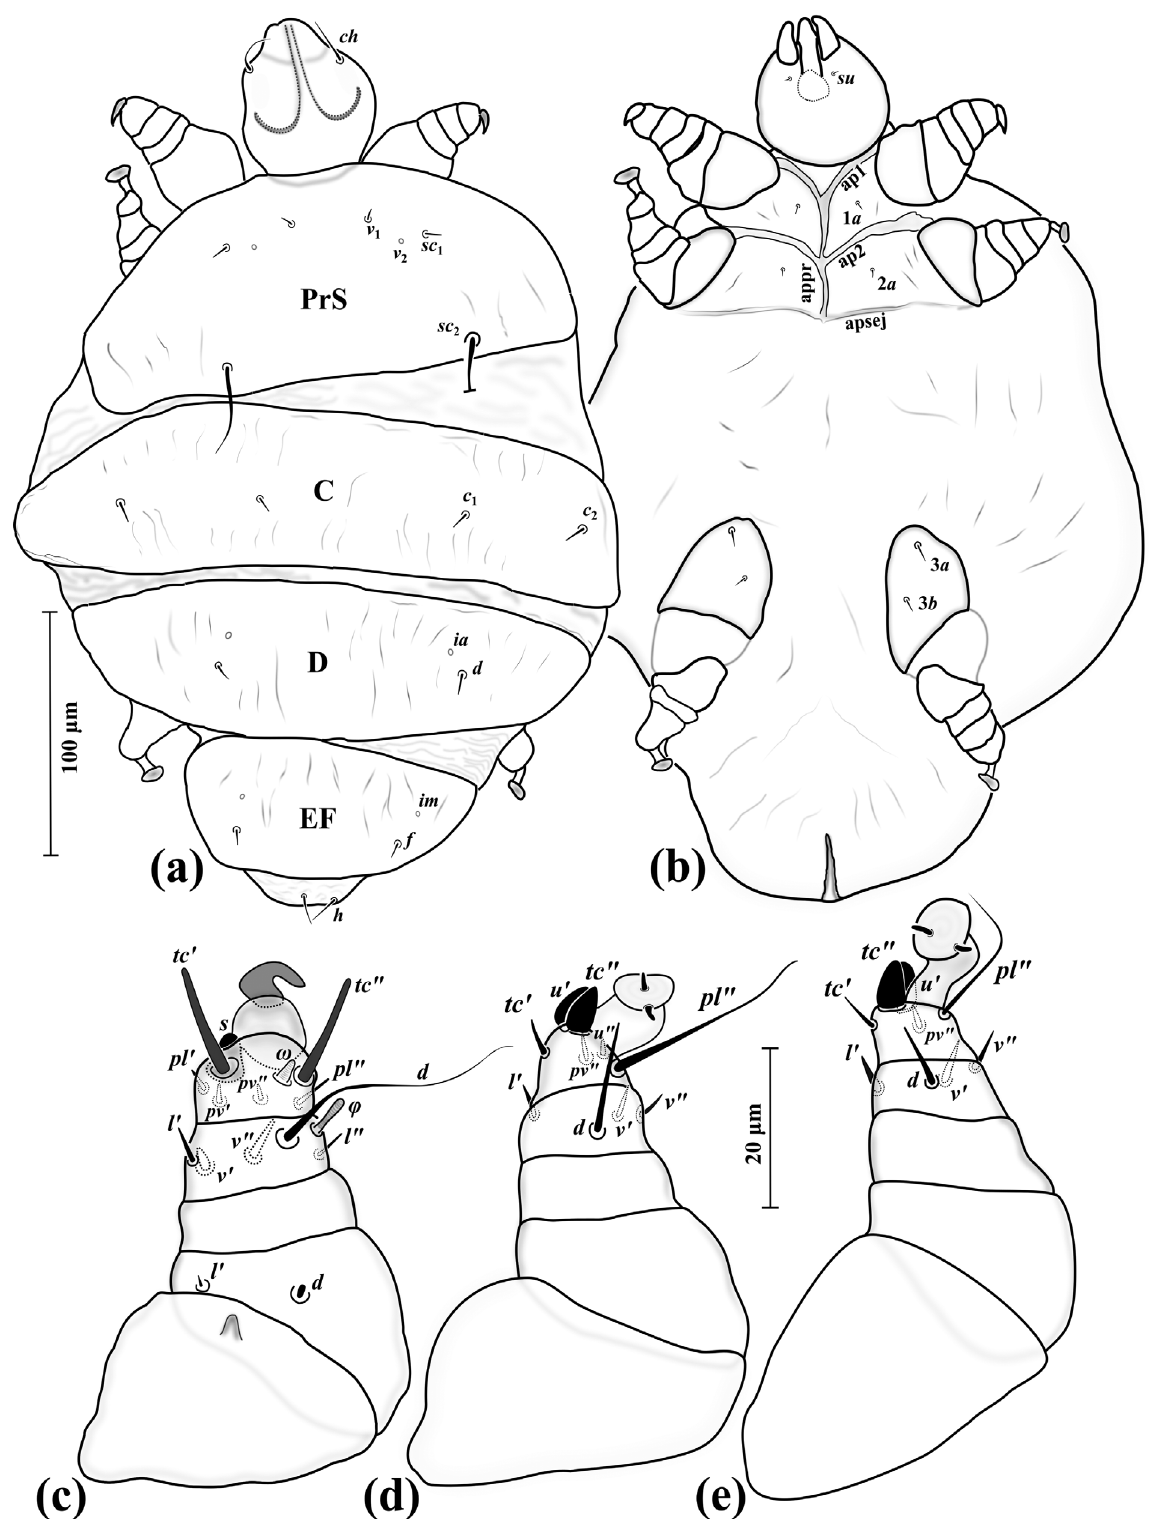
Figure 1. Eutarsopolipus paryavae n. sp. (adult female). (a) Body dorsum; (b) body venter; (c) right leg I; (d) ventral view of tarsus I; (e) right leg II; (f) right leg III. All legs in dorsal